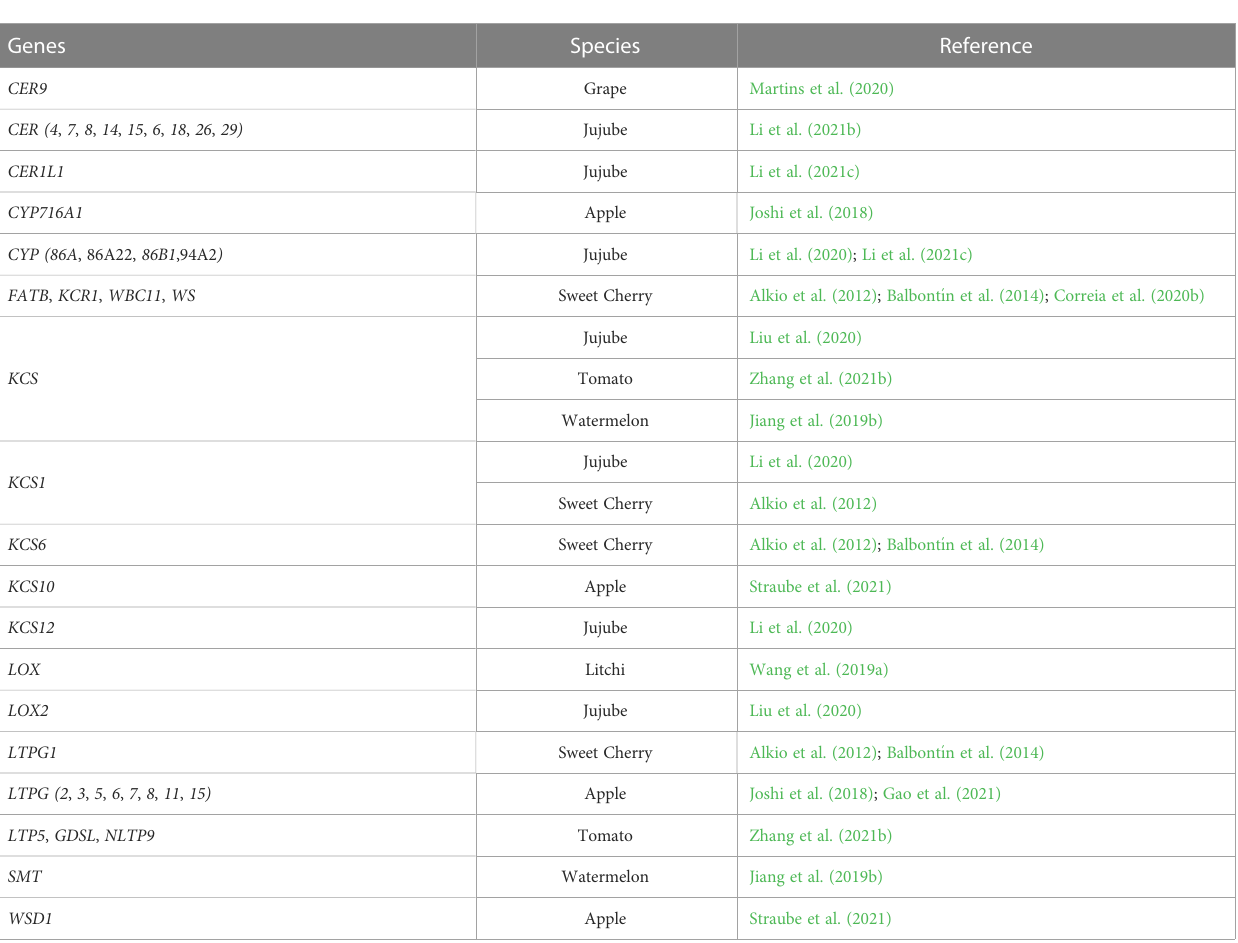
and DHCR24 (Table 1) are downregulated in cracking-susceptible watermelon (Jiang et al., 2019b).